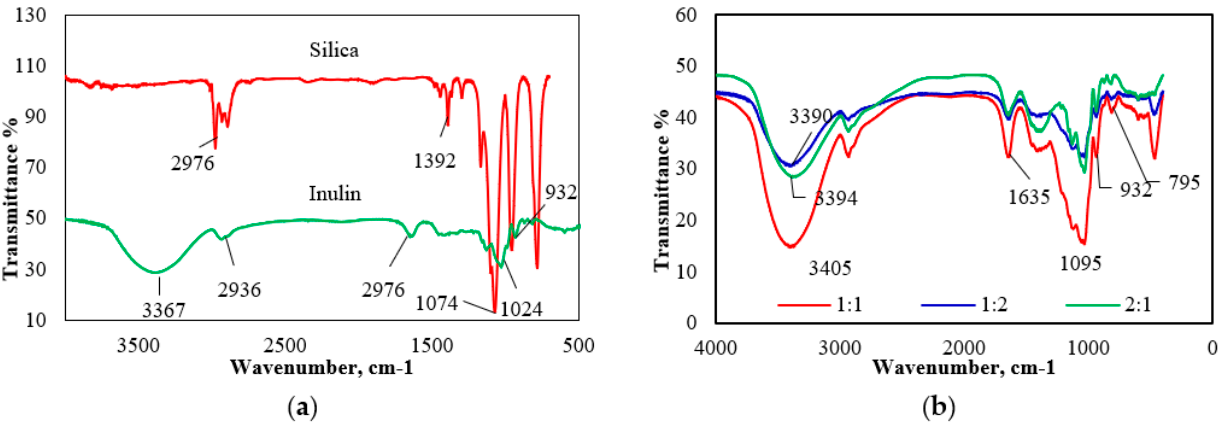
Figure 1. Comparison of FTIR spectra: ( a ) raw inulin and TEOS; ( b ) inulin–TEOS hybrid with different molar ratios. The inulin–TEOS hybrid sample with 2:1 molar ratio dried at 70 ◦ C with a